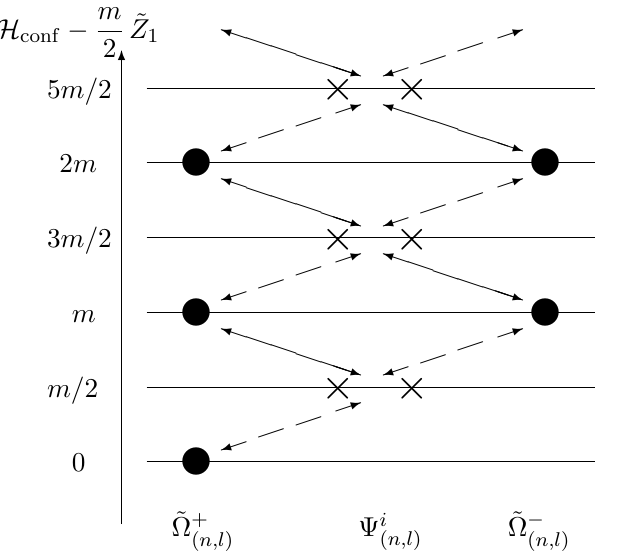
Figure 2 . Degeneracy of energy levels with a fixed number l . The action of the supercharges ¯˜ and Q j is drawn by solid lines, while dashed lines corresponds to the action of at fixed l belong to a single infinite-dimensional SU (2 | 1 , 1) representation labeled by ˜ l 2 = l 2 + g 2 as the square of the central charge. The states with − l belong to the other SU (2 | 1 , 1) representation labeled by the same ˜ l 2 = l 2 + g 2 . These two representations are distinguished only by the eigenvalue of the operator L (see discussion in subsection 3.1) and they